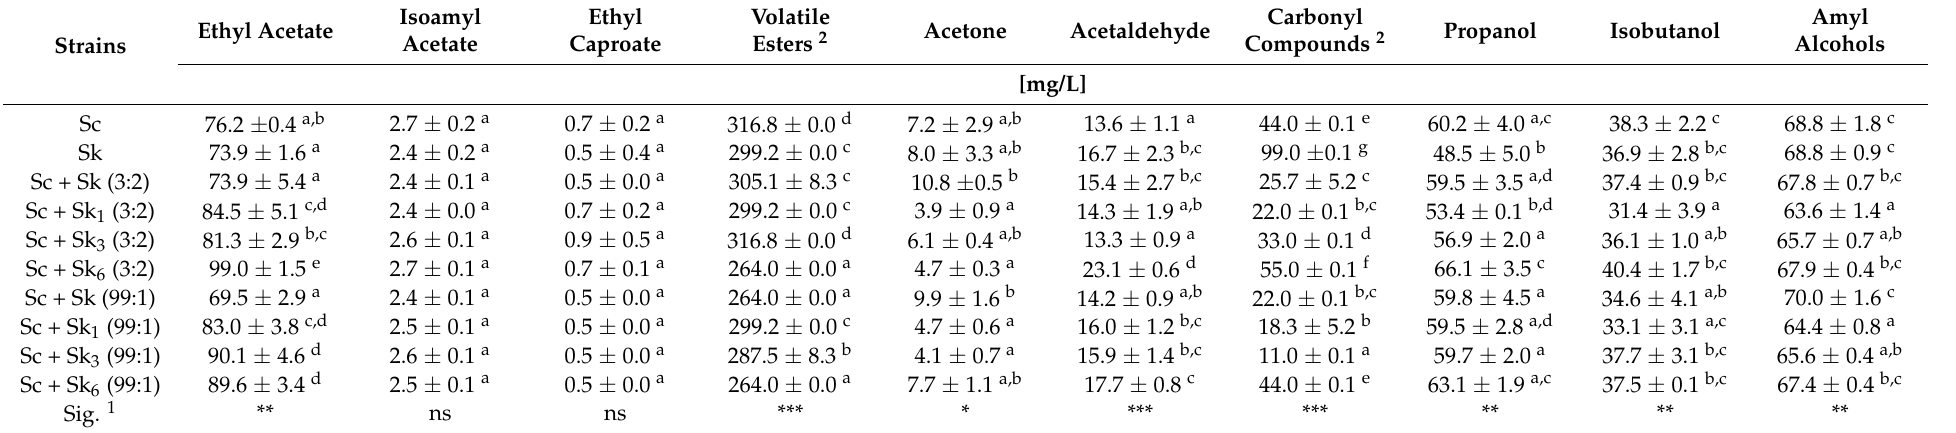
Table 2. Results of the GC-FID analysis of main volatile aroma compounds of wines obtained using monocultures or mixed cultures of Saccharomyces cerevisiae (Sc) and S. kudriavzevii (Sk).